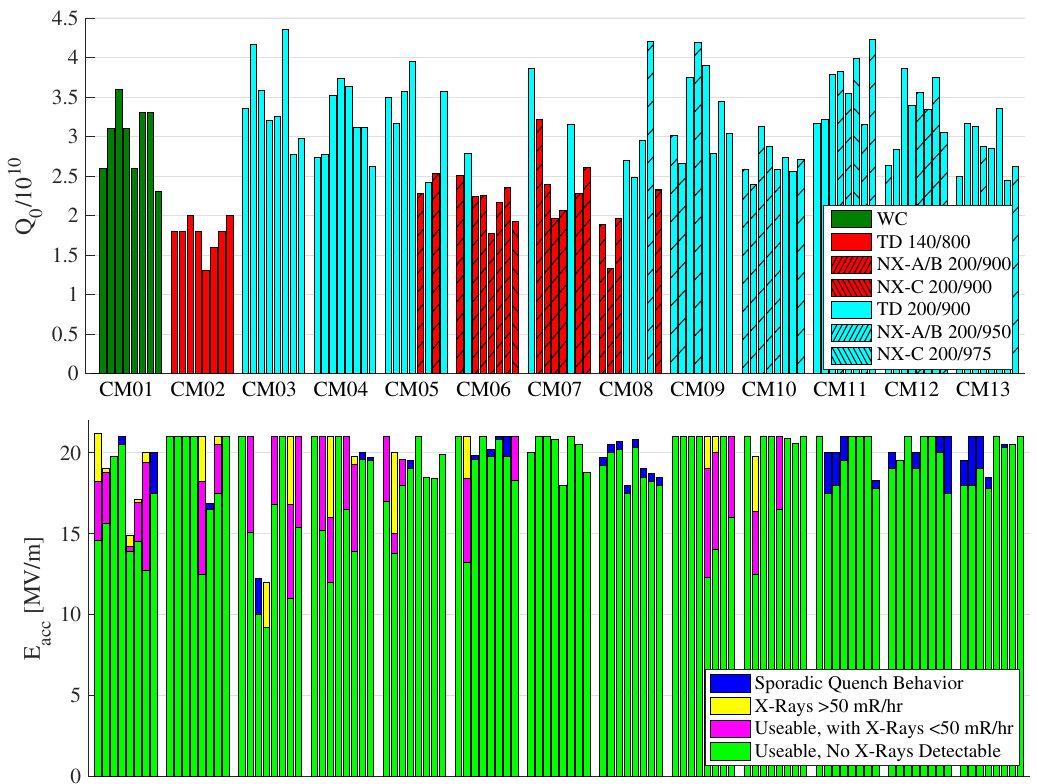
FIG. 10. Top: Q 0 measured in CMTF as a function of cryomodule number and position in cryomodule. Q 0 correlates strongly with whether the heat treatment is expected to be sufficient (blue) or insufficient (red) to cause strong flux expulsion. The prototype cryomodule CM01 was made with nonproduction material (green). All data measured at 16 MV = m and 2.0 K after high mass flow cooldown. Hatching indicates material lot. Bottom: E measurements of each cavity in the cryomodule. Additional details are given in acc the text regarding the color